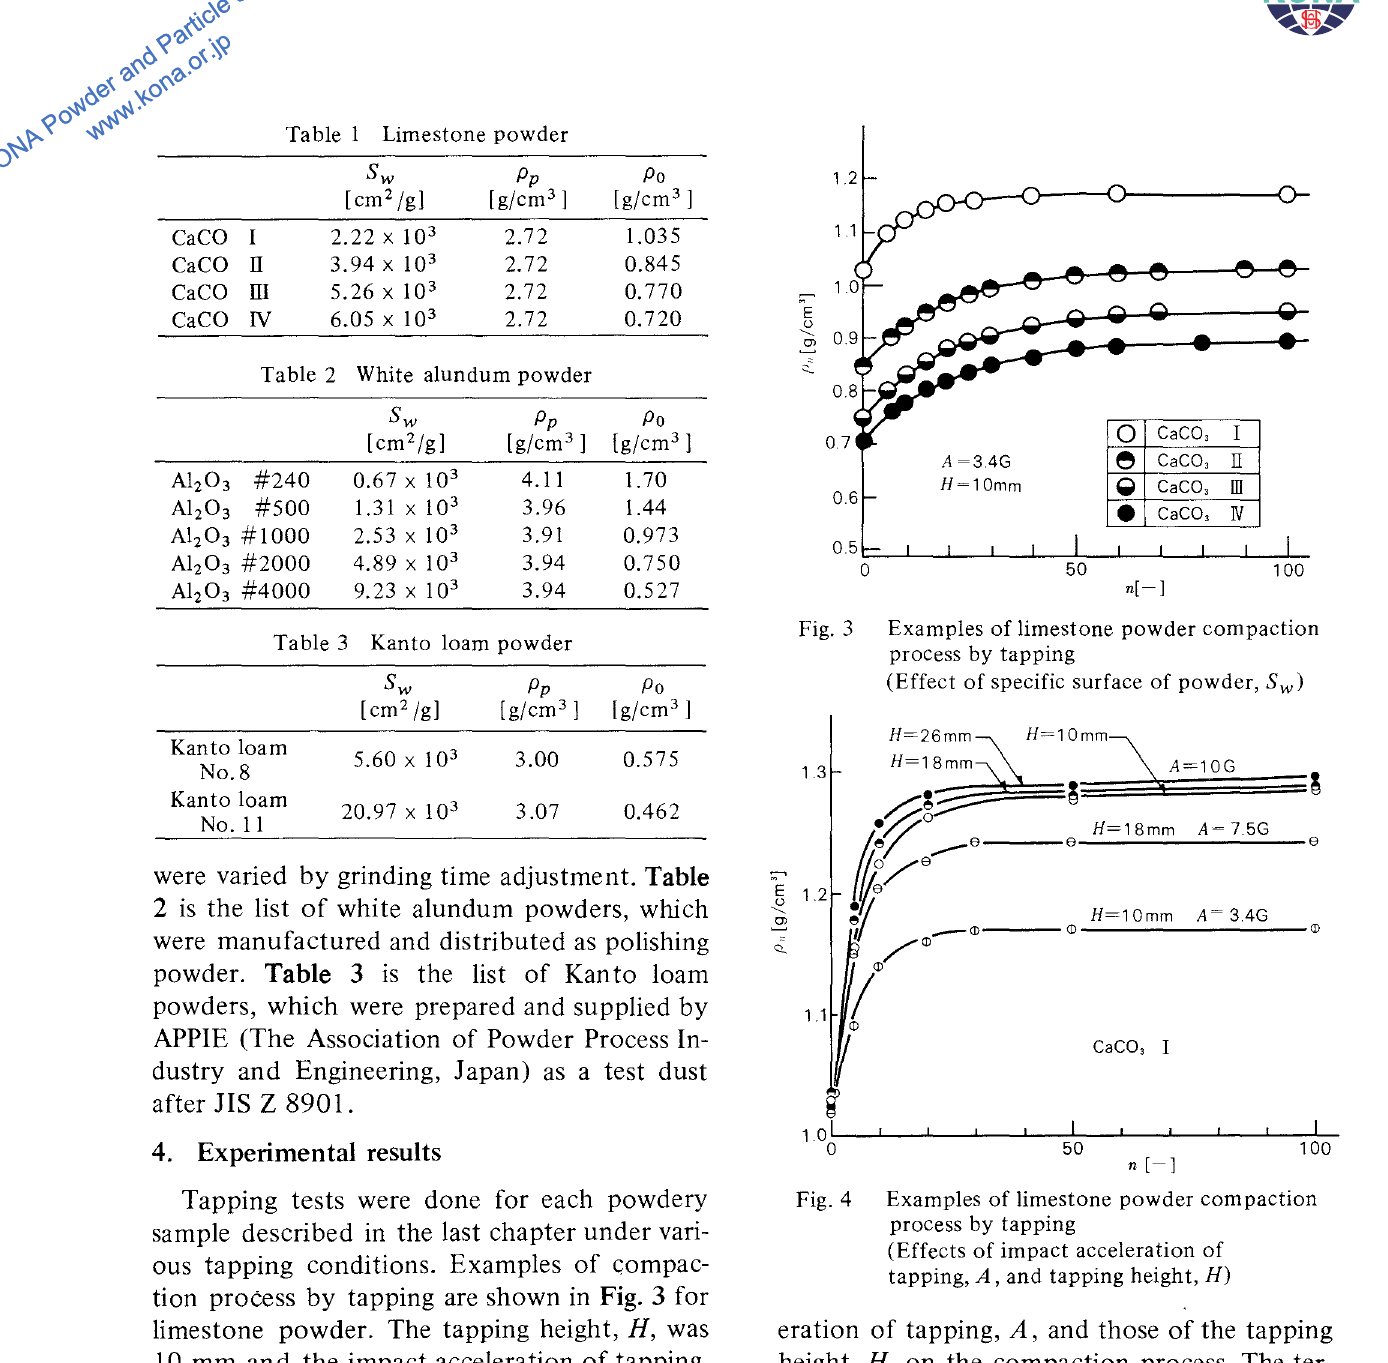
Examples of limestone powder compaction process by tapping (Effect of specific surface of powder, Sw)